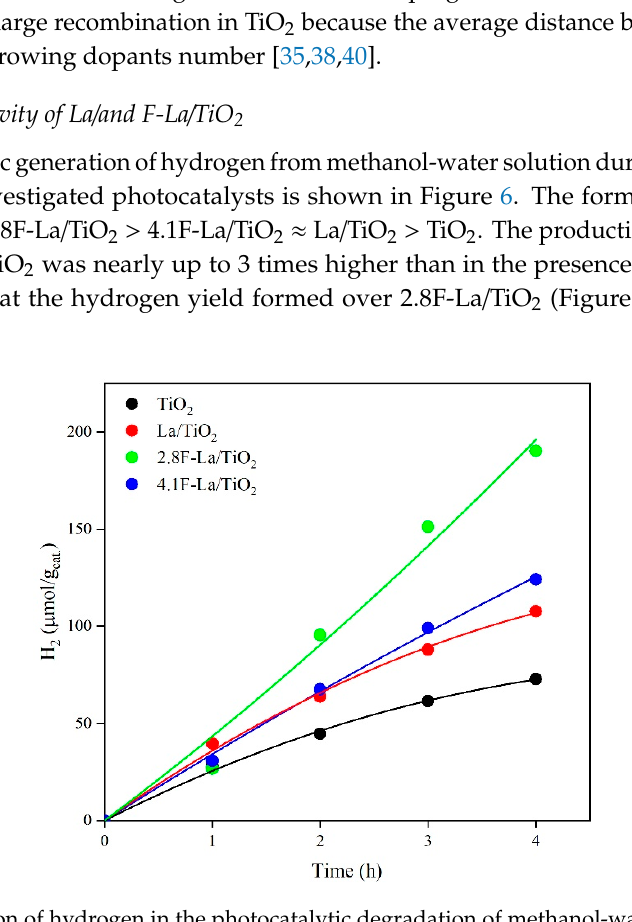
Figure 5. Electron transfer efficiency of investigated photocatalysts.